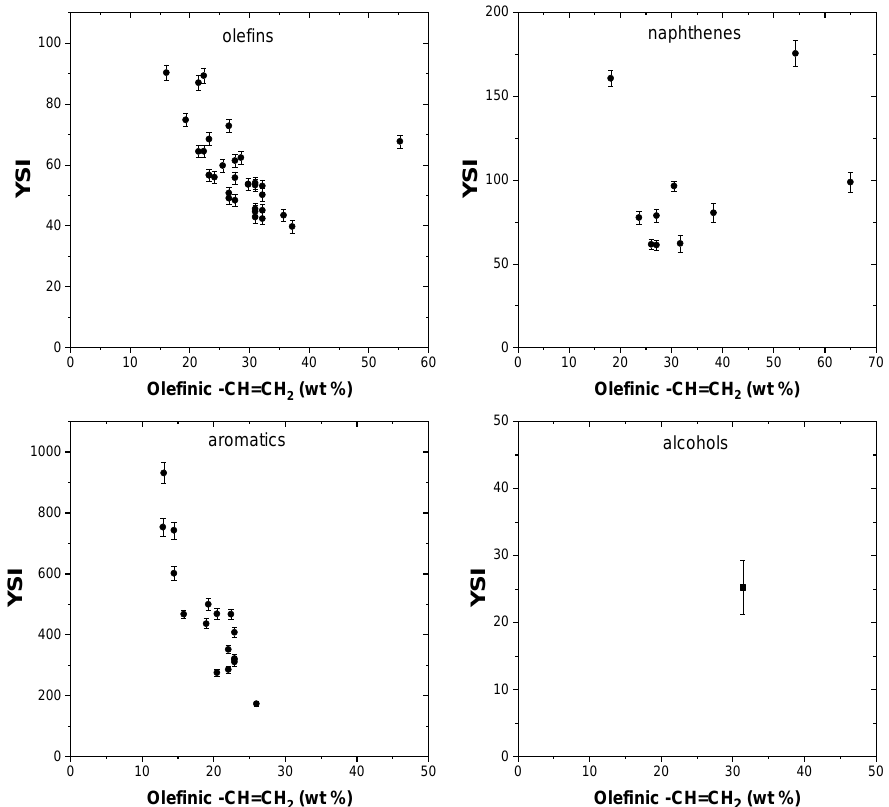
Figure 6. Effect of olefinic –CH=CH 2 groups on YSI .